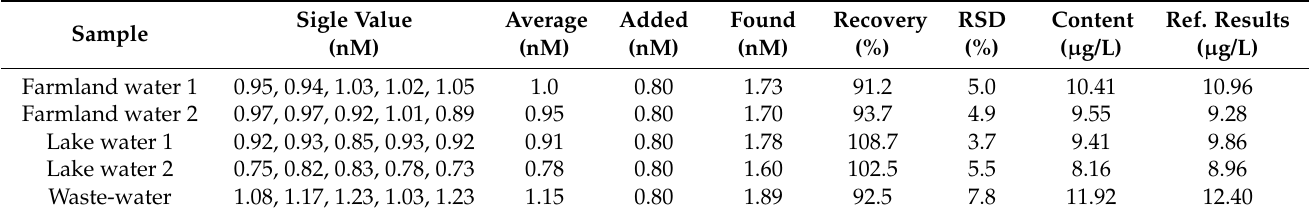
Table 2. Analytical results of Pb 2+ in water